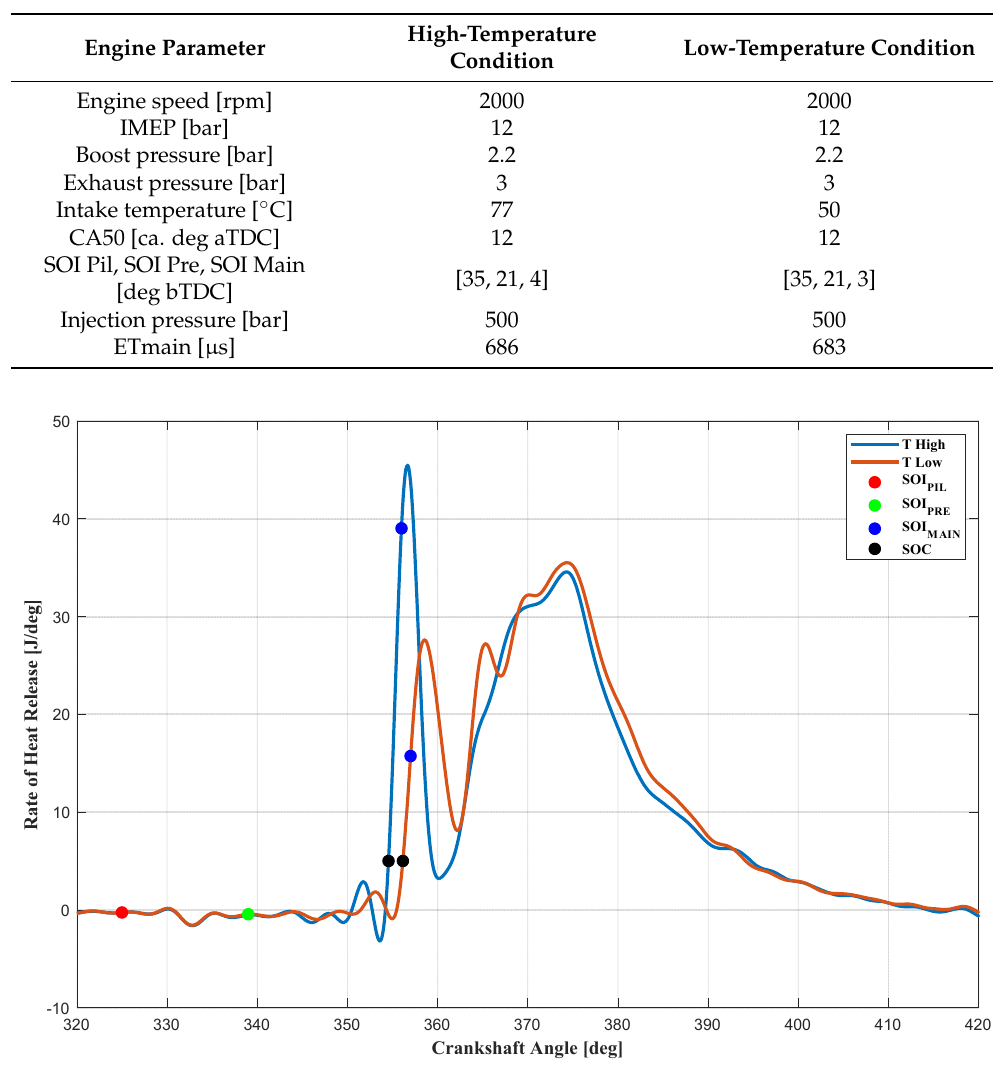
Figure 6. RoHR curves at different intake temperatures.